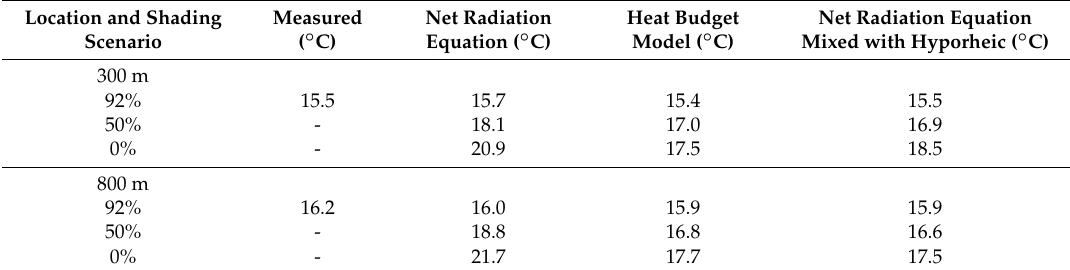
Table 6. Mean maximum stream water temperatures predicted for varying locations and shade